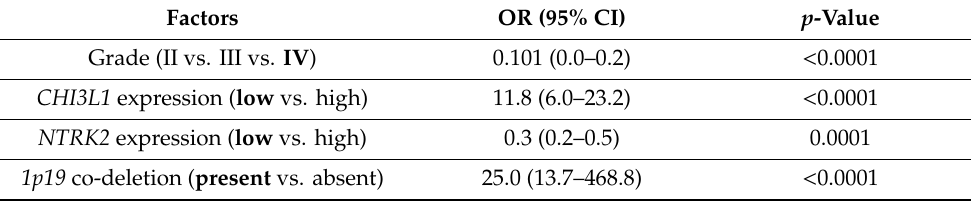
Table 1. Multivariate logistic regression model for IDH mutation.